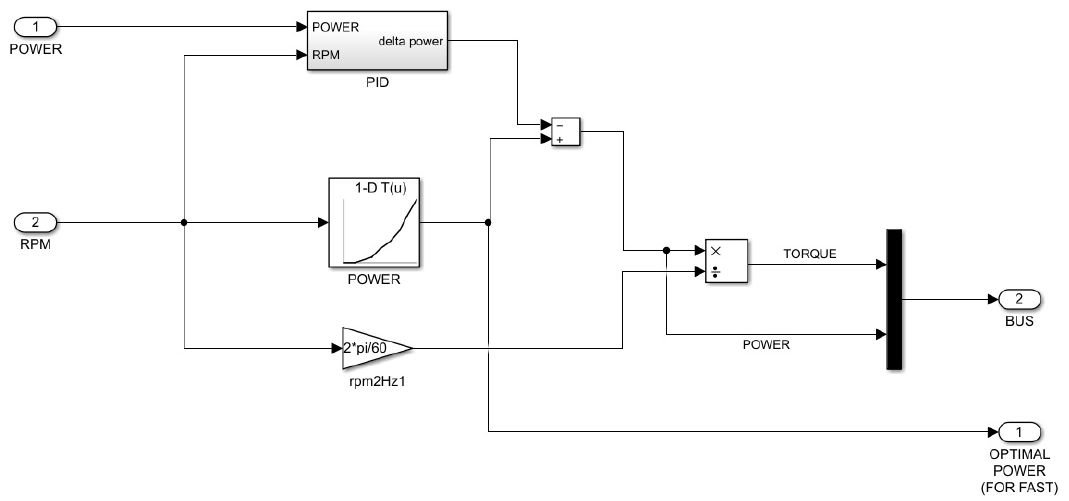
Figure 3. Simulink model of the closed loop